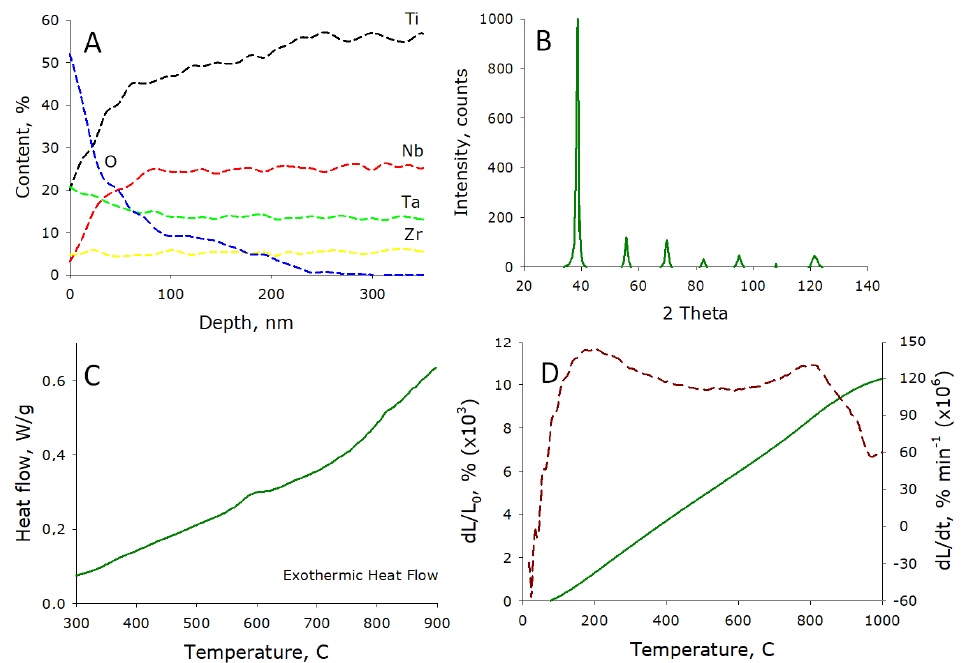
Figure 1. Properties of the Ti–25Nb–13Ta–5Zr alloy. ( A ) Layer-by-layer analysis of the surface